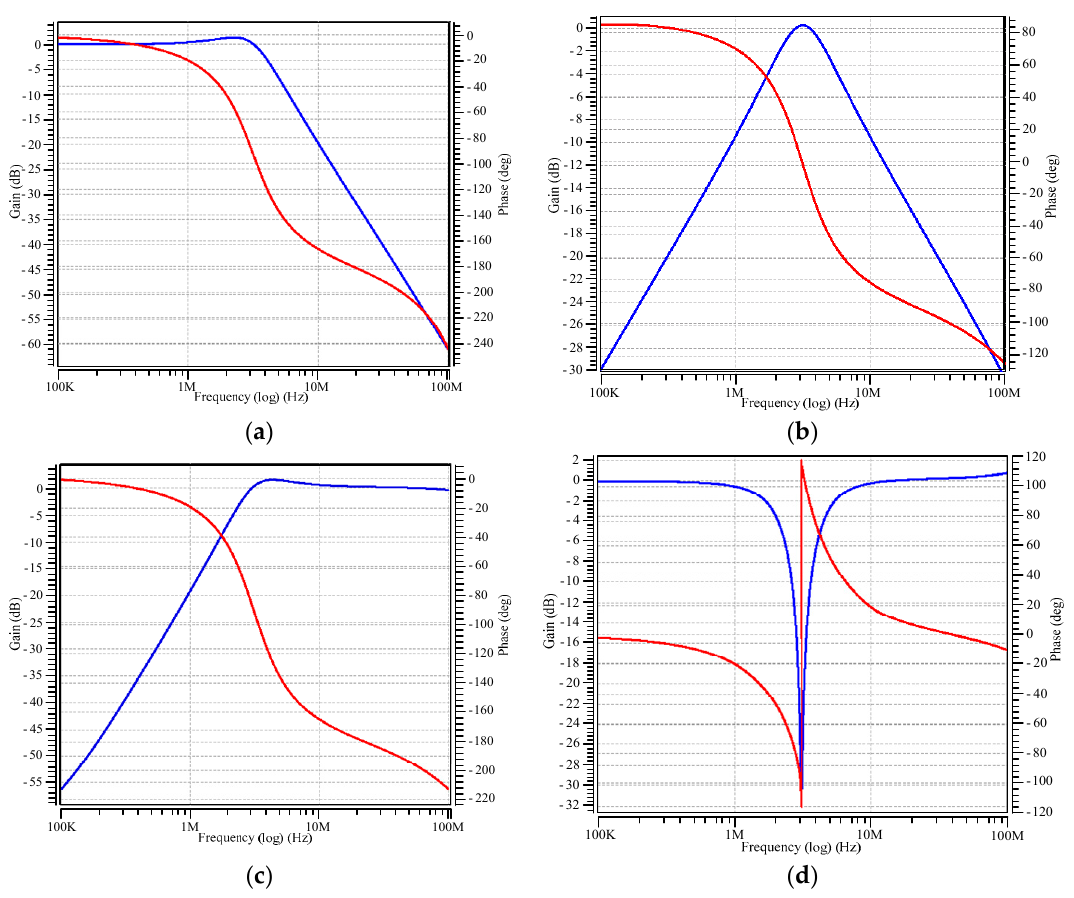
Figure 17. The VM post-layout gain (blue line) and phase (red line) simulation responses ( a ) lowpass filter (V o1 /V in ); ( b ) bandpass filter (V o2 /V in ); ( c ) highpass filter (V o3 /V in ); and ( d ) bandstop filter (V o4 /V in ). Appl. Sci. 2017 , 7 , 244